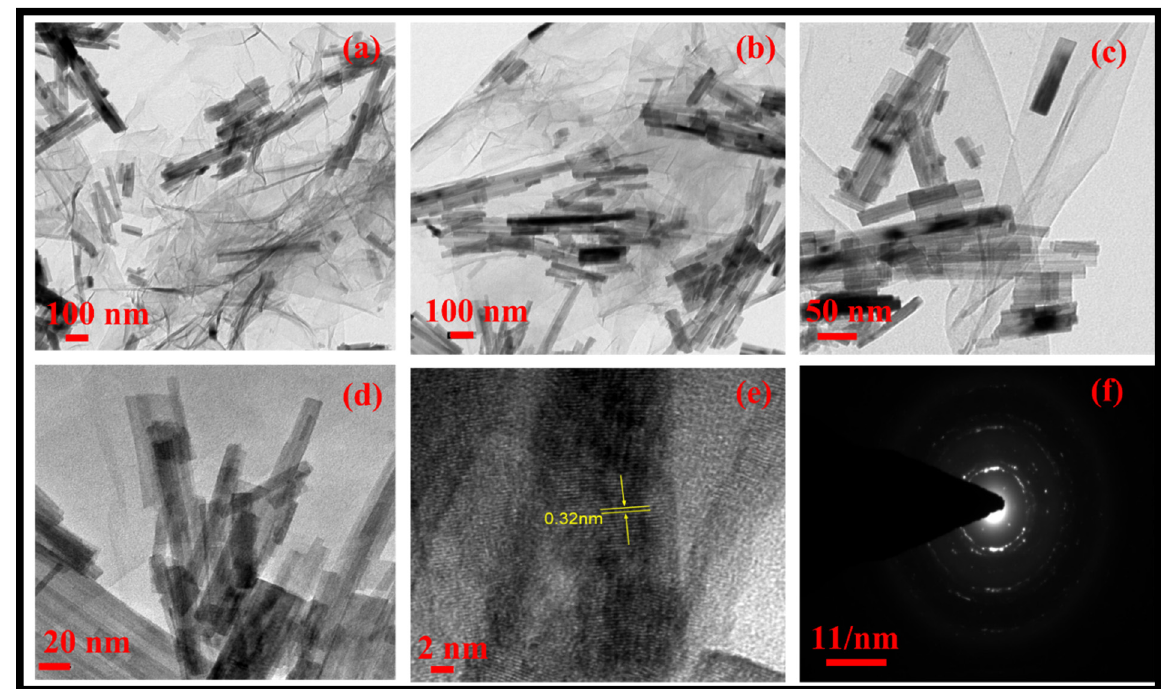
Figure 1. Typical ( a , b ) TEM images of WO 3 nanorods.